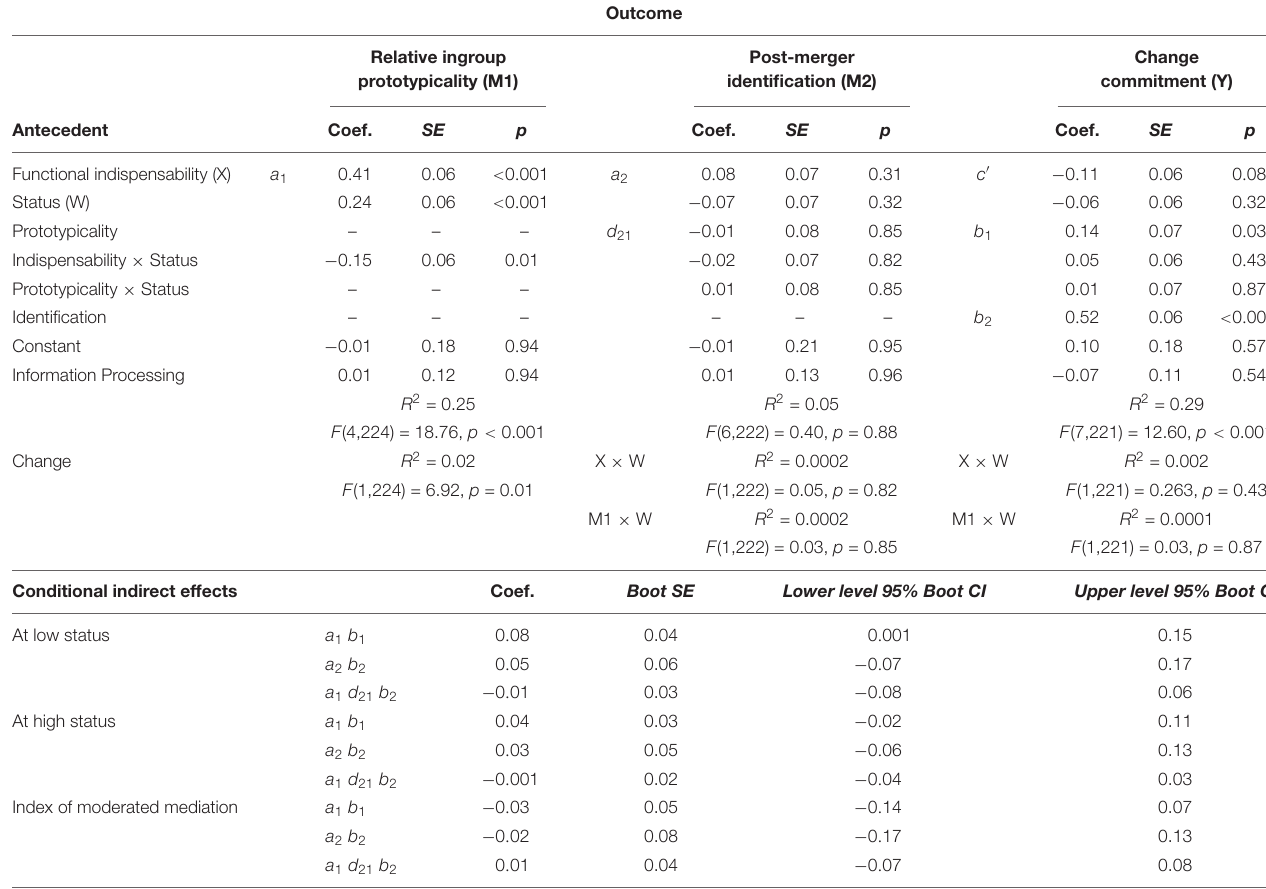
TABLE 6 | Summary of sequential mediation, Study 5 ( Figure 1 for